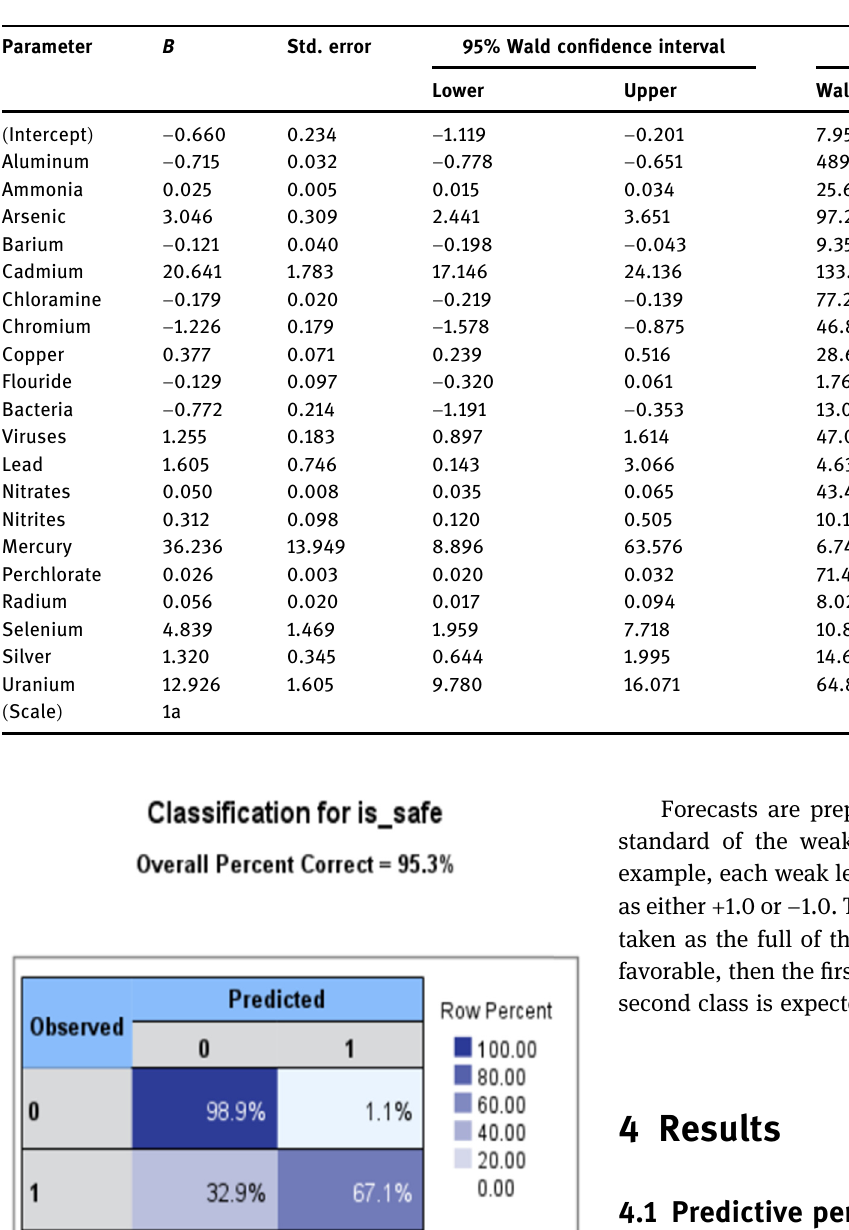
Table 5: Evaluation of linear regression